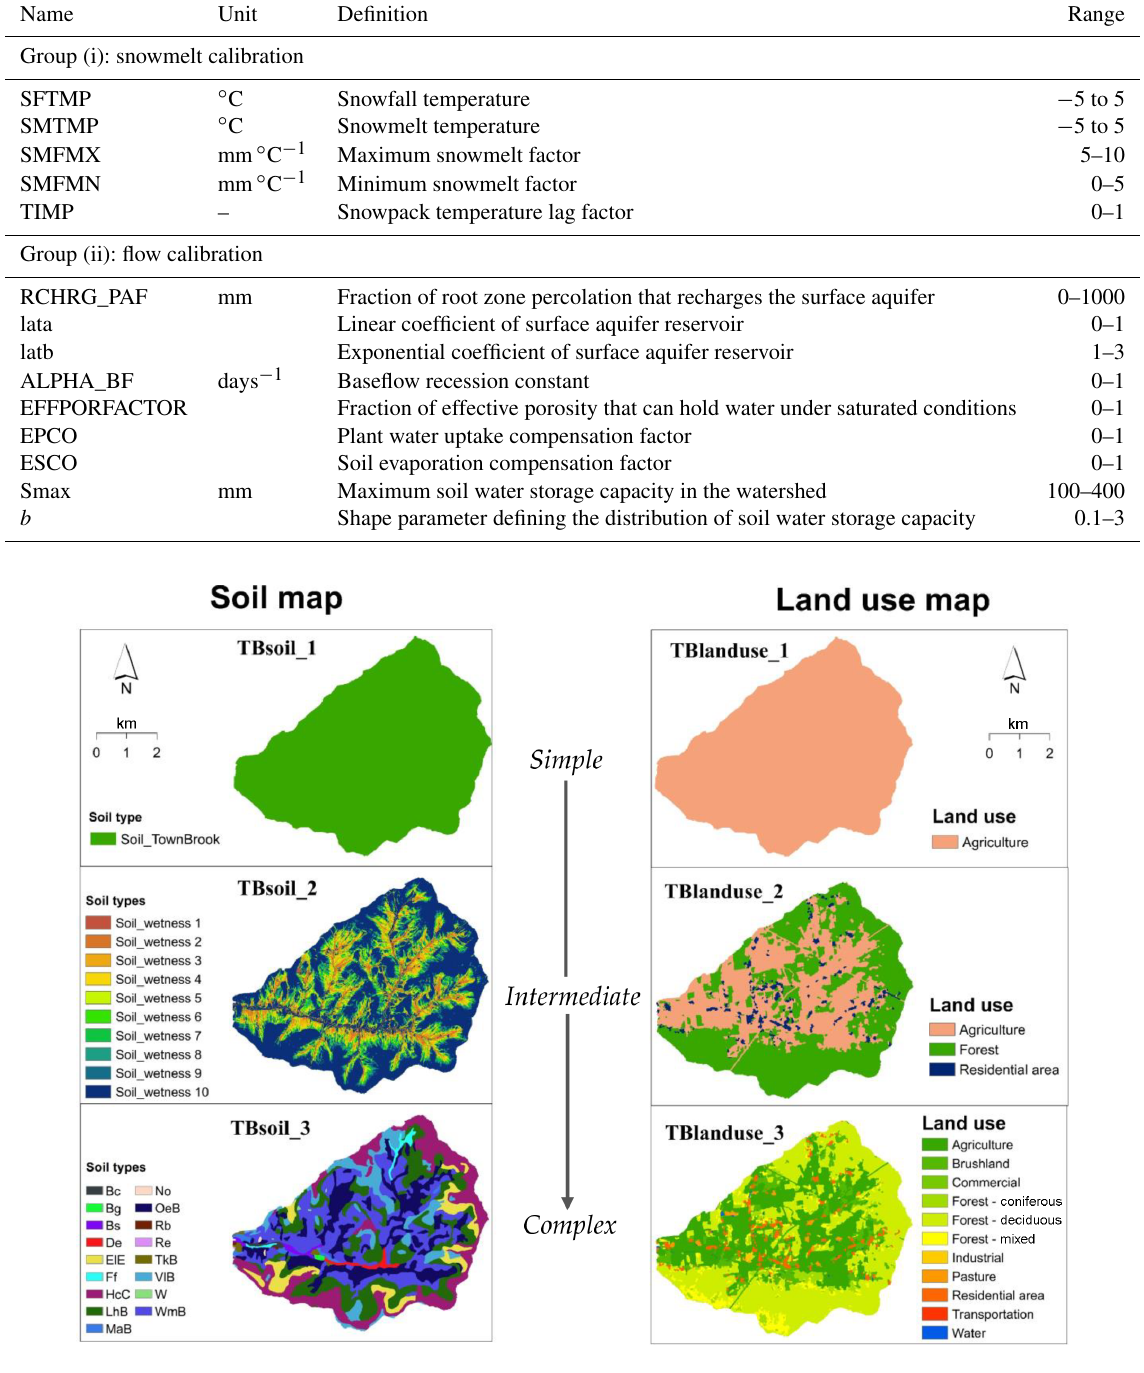
Figure 2. Soil and land use maps with increasing levels of complexity to build SWAT-HS model